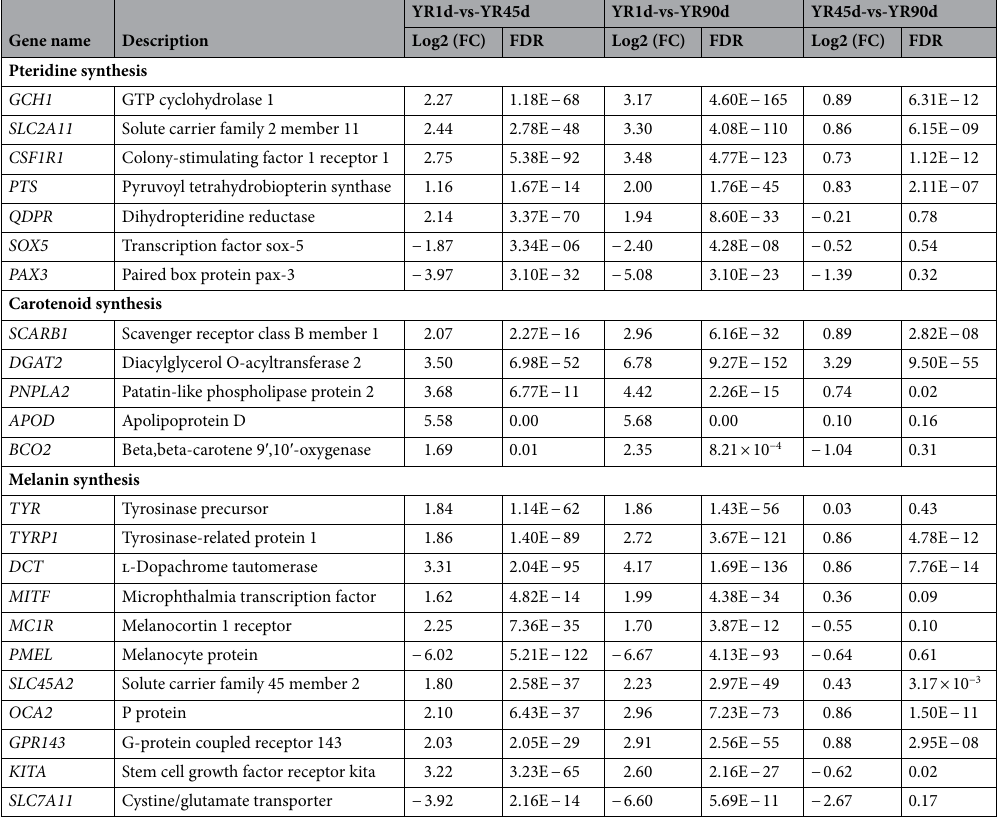
Table 3. Representative pigmentation-related genes differentially expressed in each compared